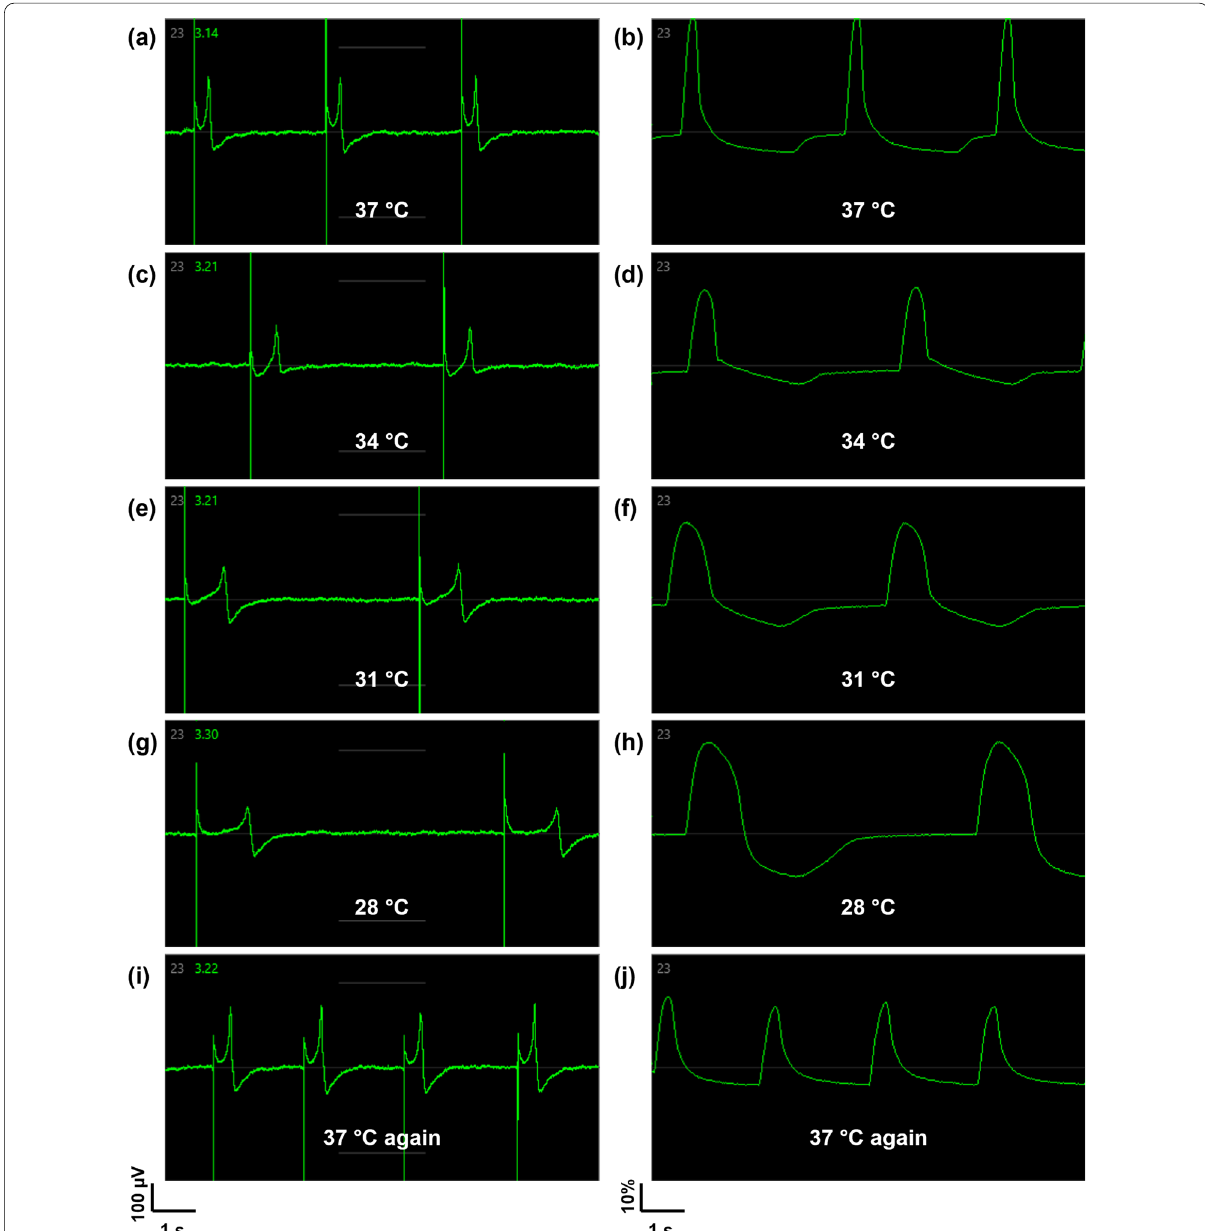
Fig. 3 Field potential (left) and contractility (right) recorded data at the system temperature of a , b 37 °C, c , d 34 °C, e , f 31 °C, g , h 28 °C and i , j raised back to 37